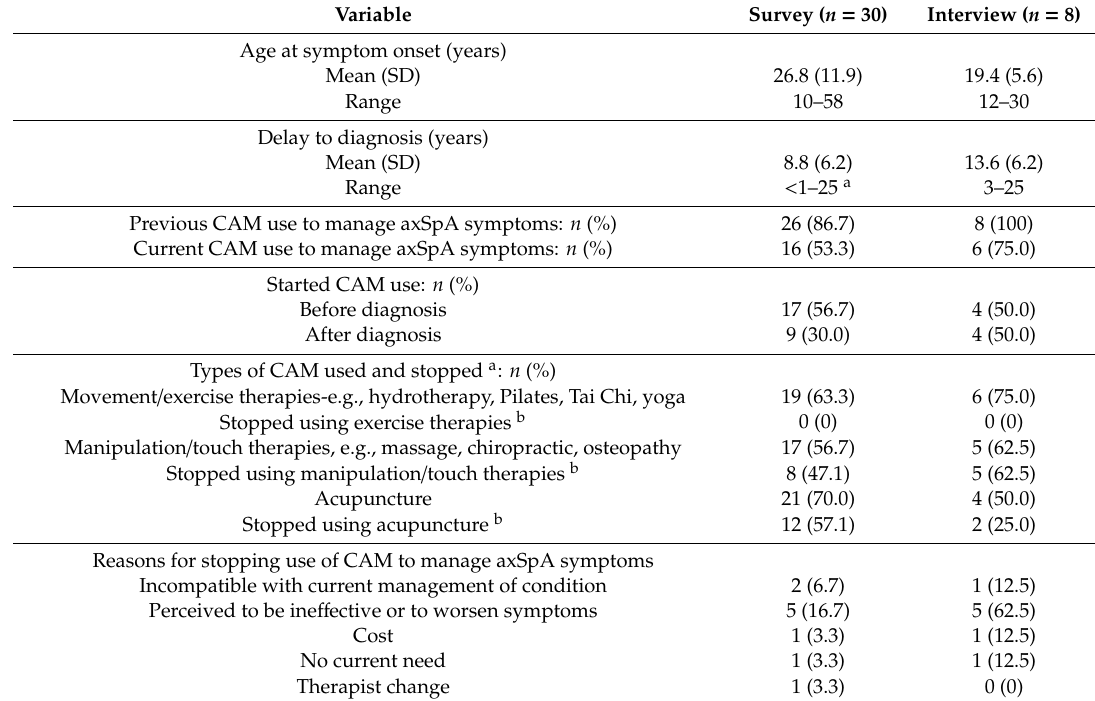
Table 3. Complementary and alternative medicine therapies (CAM) use in survey and interview participants.